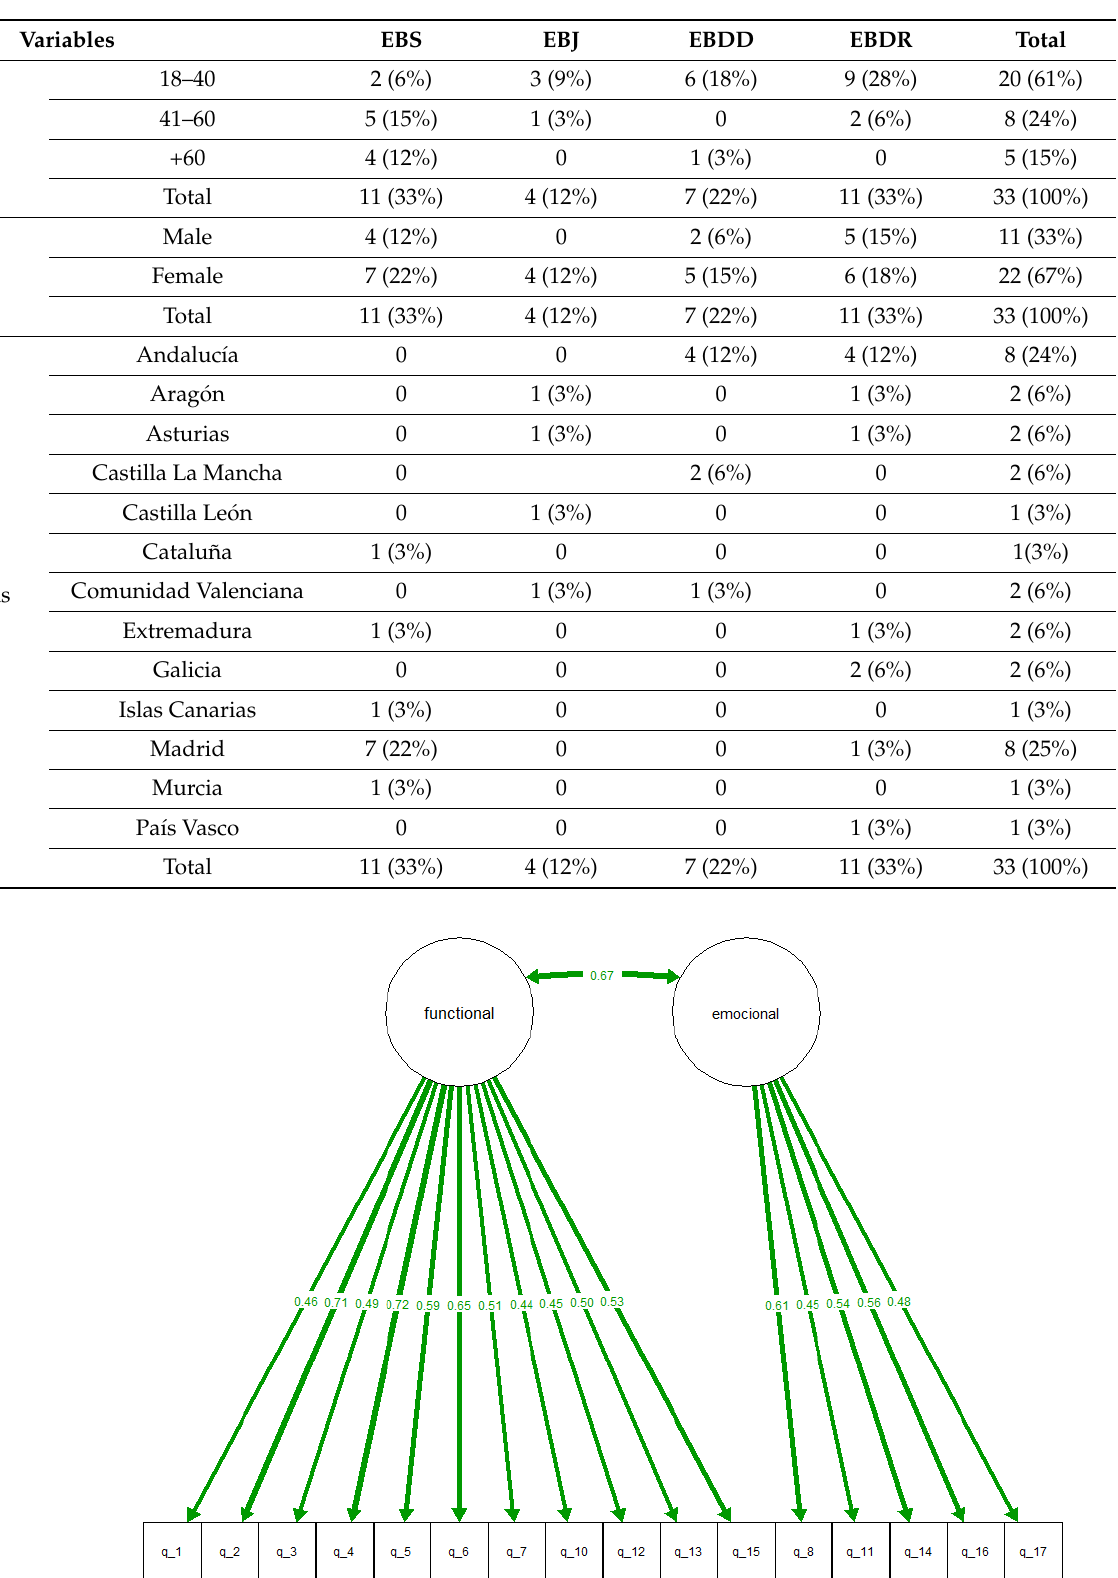
Figure 1. Confirmatory factor analysis of the results of the Spanish version of the QoLEB.